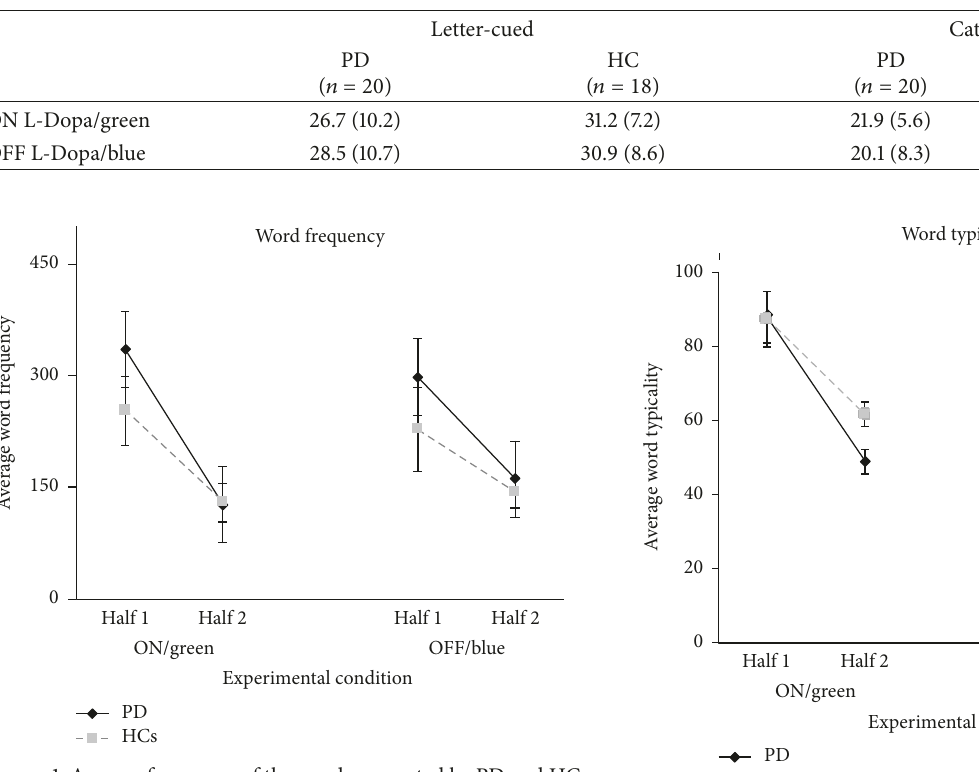
Figure 1: Average frequency of the words generated by PD and HC in both halves of trials of the phonemic fluency task, reported for both ON/green and OFF/blue experimental conditions. Figure 2: Average typicality of the words generated by PD and HC inbothhalvesoftrialsofthesemanticfluencytask,reportedforboth ON/green and OFF/blue experimental